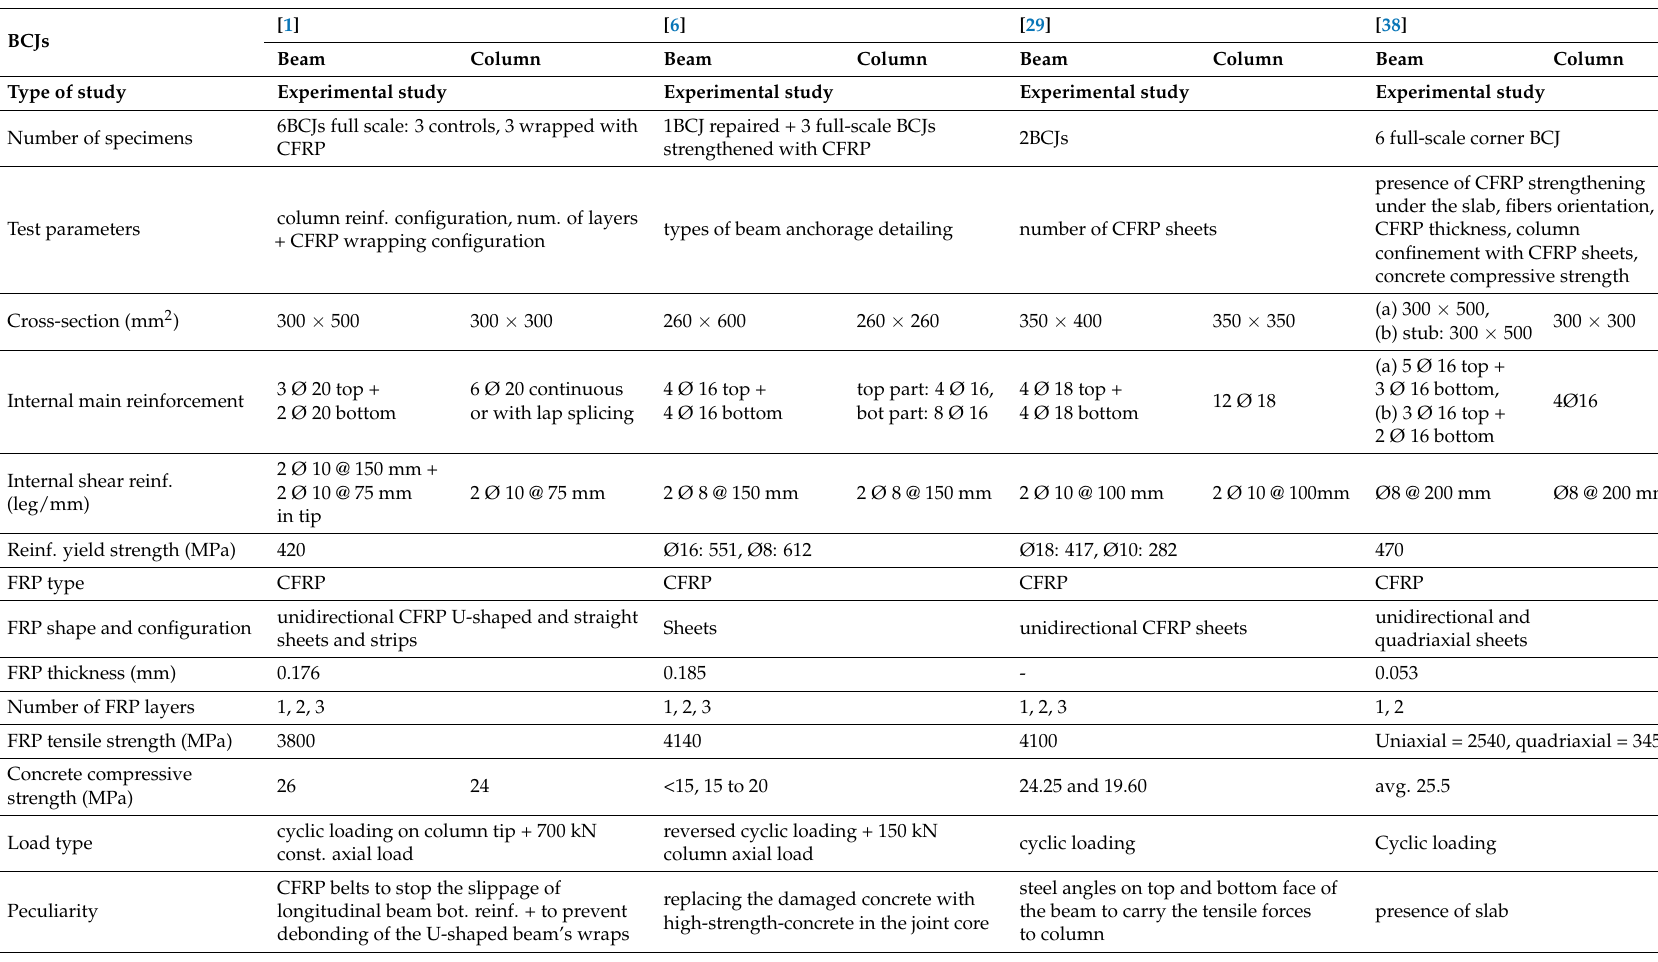
Table 3. Summary of experimental work on full-scaled BCJs externally reinforced with one FRP